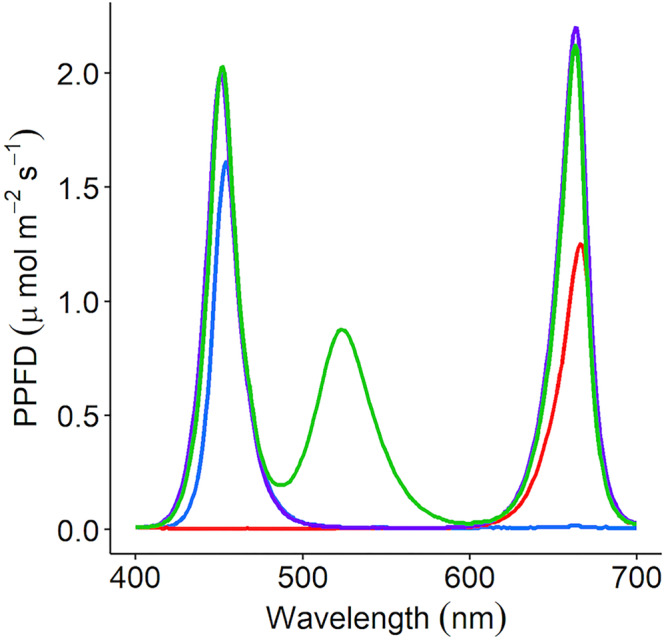
C. sativum was grown under four separate irradiance spectrums using LED lamps; red (peak: 666nm), blue (peak: 454 nm), RB [red (663 nm) + blue (451 nm)], and RGB [red (663 nm) + green (523 nm) + blue (451 nm)]. Each lamp was adjusted to supply 150 μmol m–2 s–1 photosynthetic photon flux density (PPFD). The supplemental LED lights used in the commercial glasshouse output the red + green + blue (35.8% red: 26.4% green: 37.8% blue—RGB) spectrum.